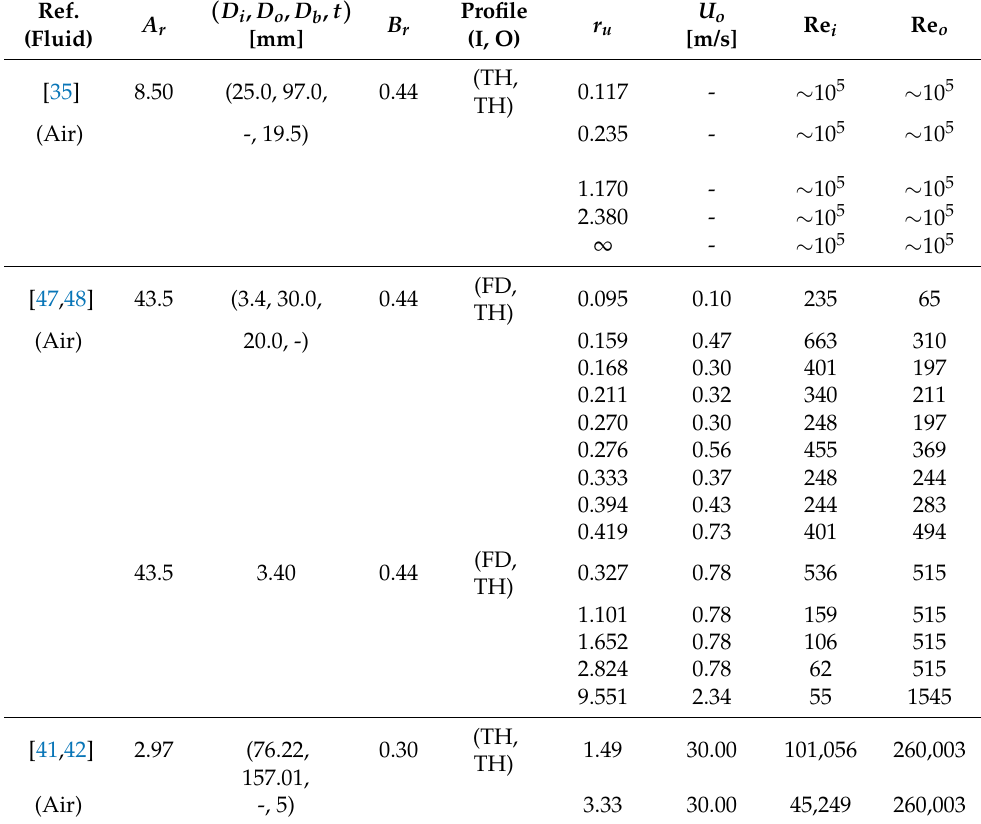
Figure 7. Streamline patterns for a coaxial jet having having a blockage disk installed. ( a ) Laser doppler anemometry measurements, r u = 2.38, B r = 0.44 [47], ( b ) PIV measurements, r u = 0.155, B r = 0.55 [45]. “SP”,“SC” and “TV” denote stagnation point, stagnation circle and toroidal vor- tices, respectively. Table 3. Overview of literature publications on coaxial jets having a blockage disk installed or having t > 2 mm. “TH” and “FD” denote “Top hat” and “Fully developed turbulent pipe flow” jet exit profiles, respectively. “I” and “O” denote “inner” and “outer” jet, respectively.